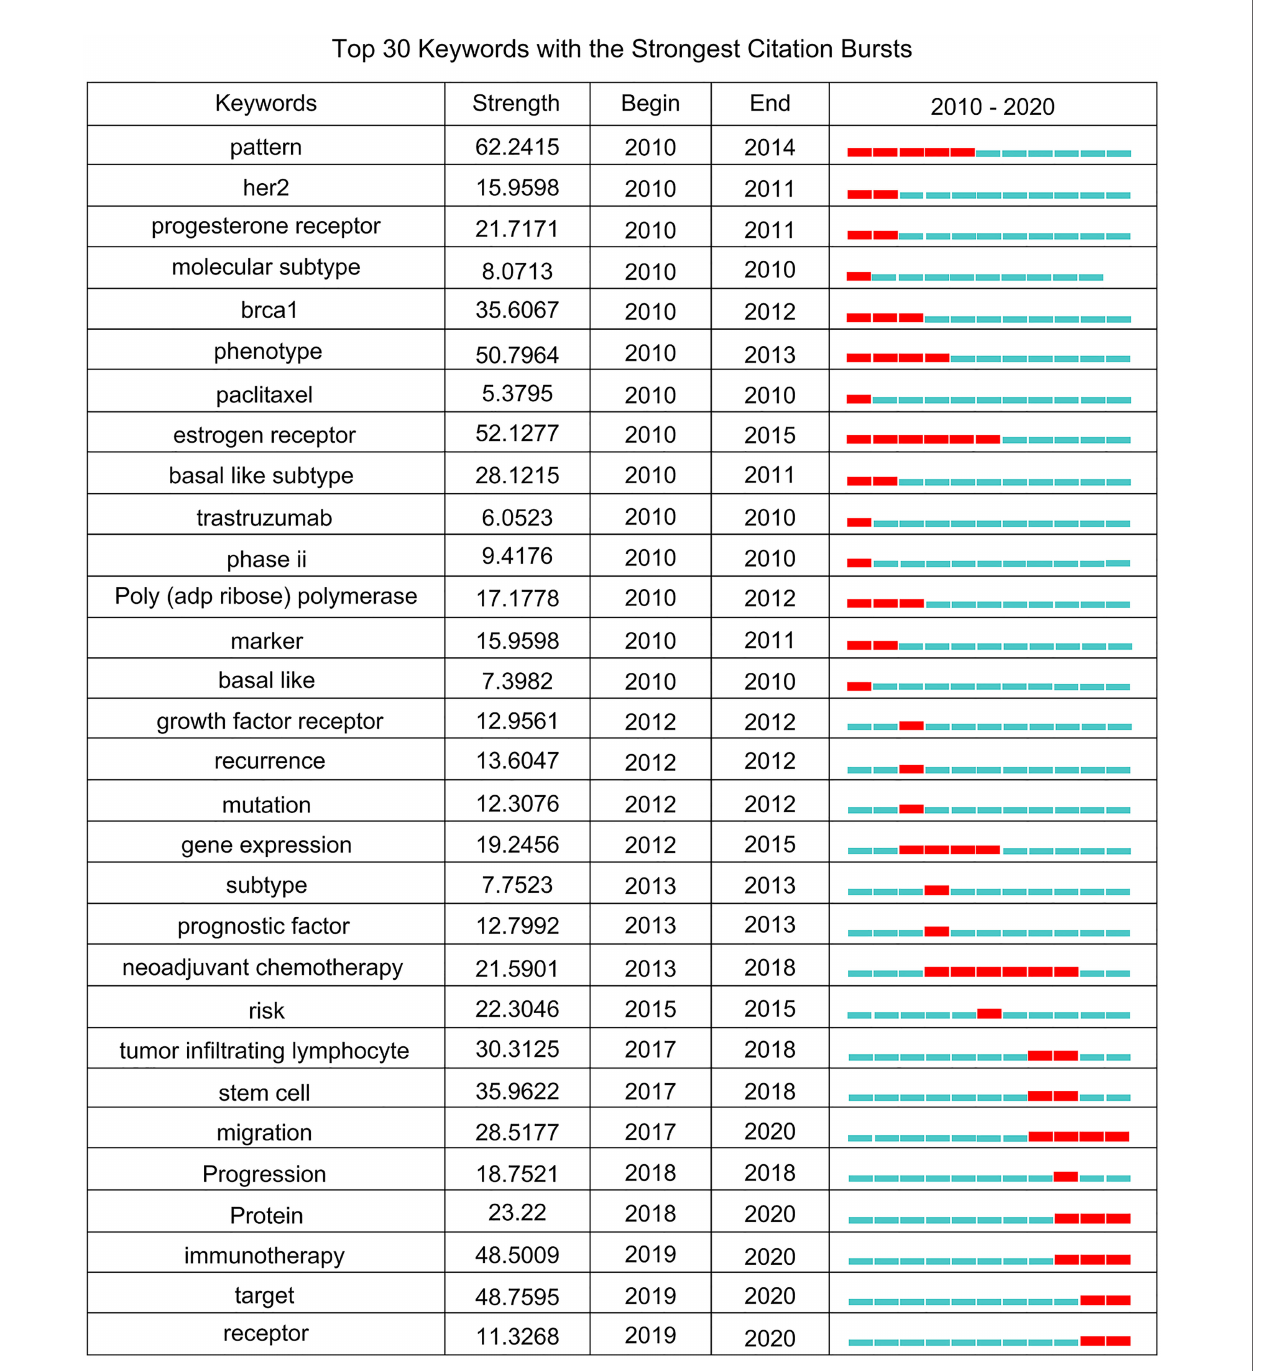
FIGURE 6 | The evolution trend of burst words on TNBC from 2010 to